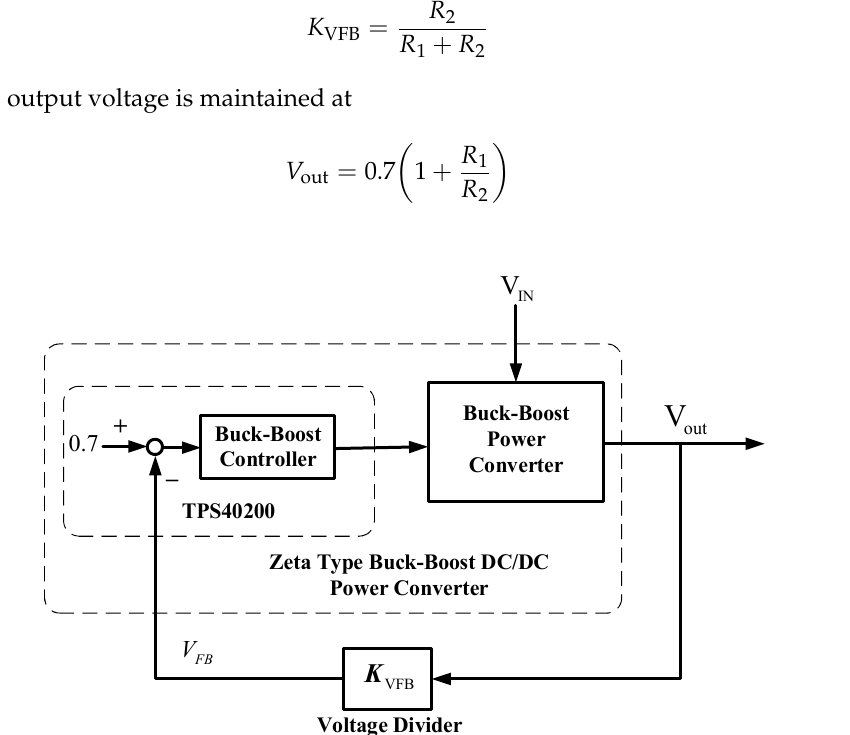
Figure 3. Feedback control loop of the buck-boost converter.